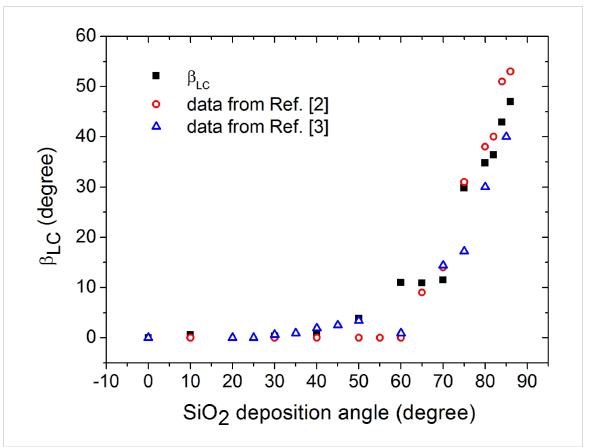
Figure 5: LC pretilt vs the SiO 2 deposition angle. The experimental data from [2] and [3] are shown for